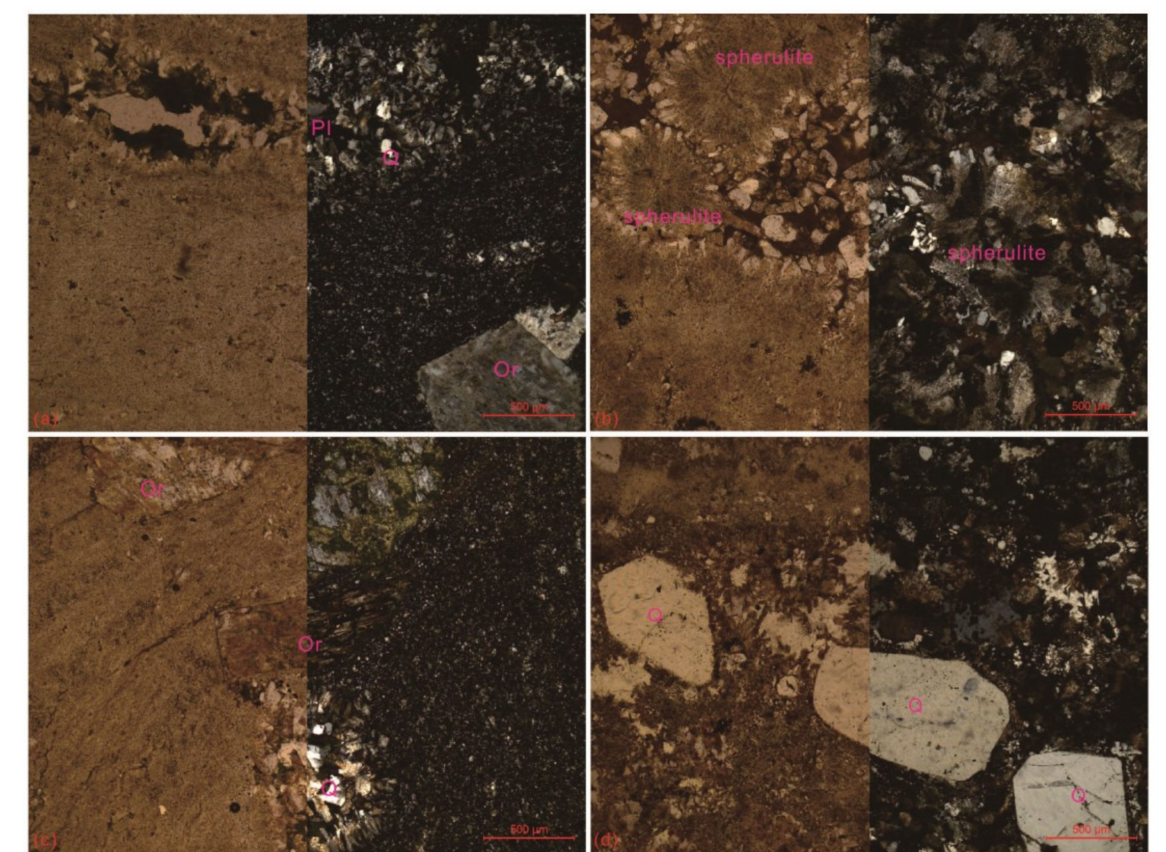
Figure 4. Photomicrographs of the Keri rhyolites in the EKOB. ( a ) Photomicrographs of the rhy- olitic brecciated tuff lavas (sample XRD110-6); ( b ) spherulite texture of the rhyolitic brecciated tuff lavas (samples XRD111-1); ( c ) photomicrographs of the rhyolitic tuff lavas (sample KR570-4); ( d ) photomicrographs of the rhyolitic tuff lavas (sample KR570-5). Mineral abbreviations are as follows: Q = quartz, Or = K-feldspar, Pl =